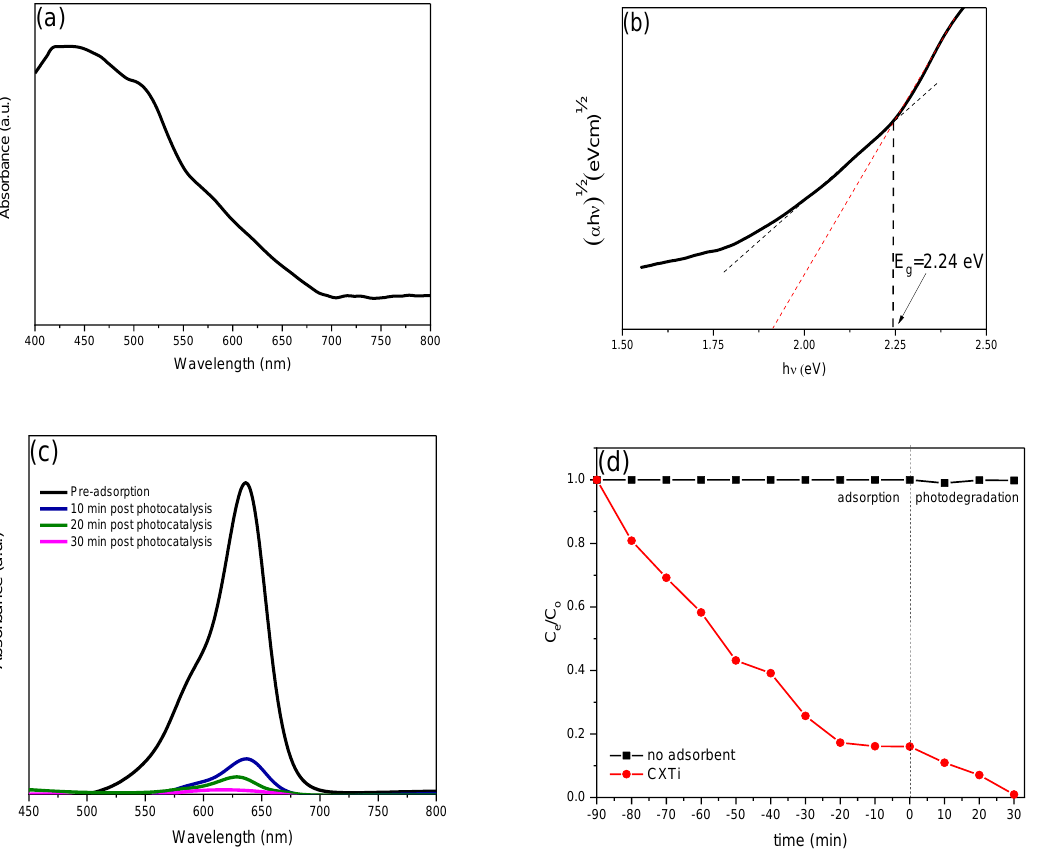
Figure 10. ( a ) UV-Vis absorption spectrum of CXTi synthesised in this study, ( b ) Tauc plot of CXTi, ( c ) post adsorption photocatalytic performance of CXTi under visible light irradiation and ( d ) kinetics of combined adsorption and photodegradation of MB on CXTi.